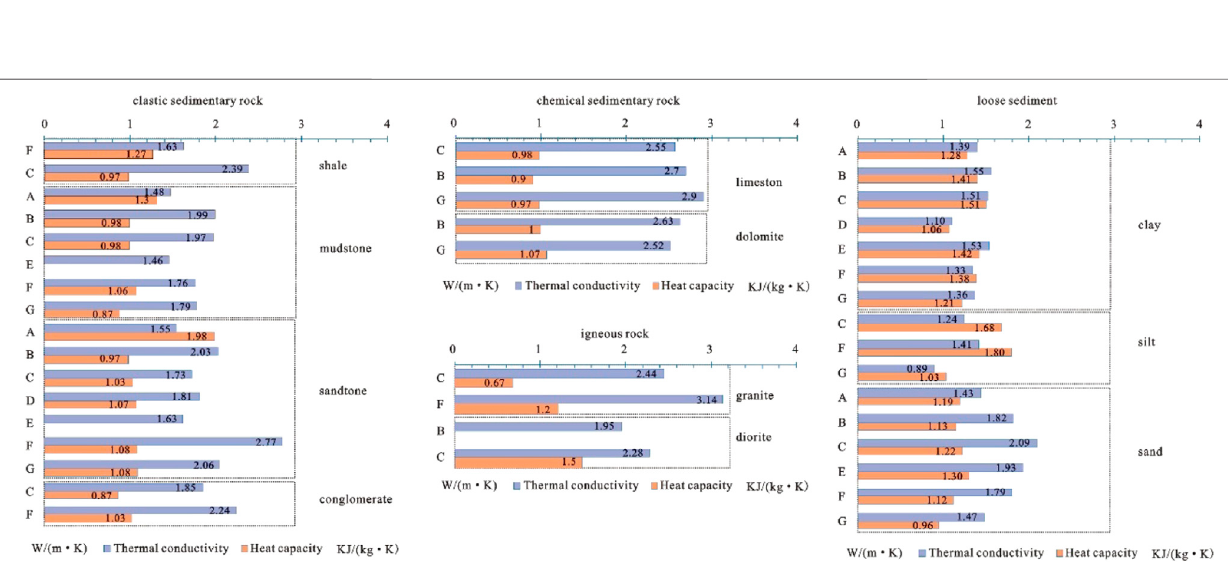
Frontiers in Earth Science |